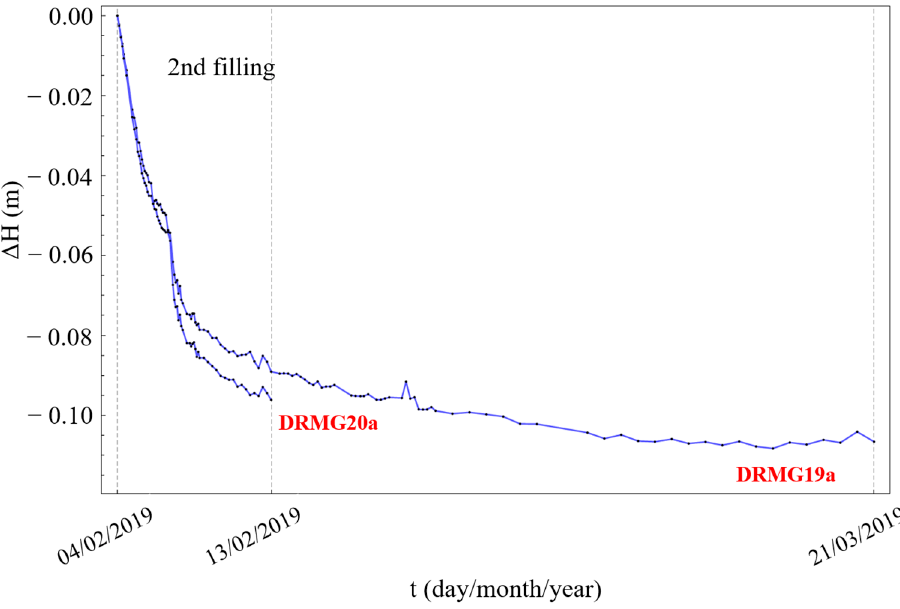
Figure 9. Settlement visualization of points DRMG19a and DRMG20, from 04/02/2019 to 21/03/2019 (13/02/2018).